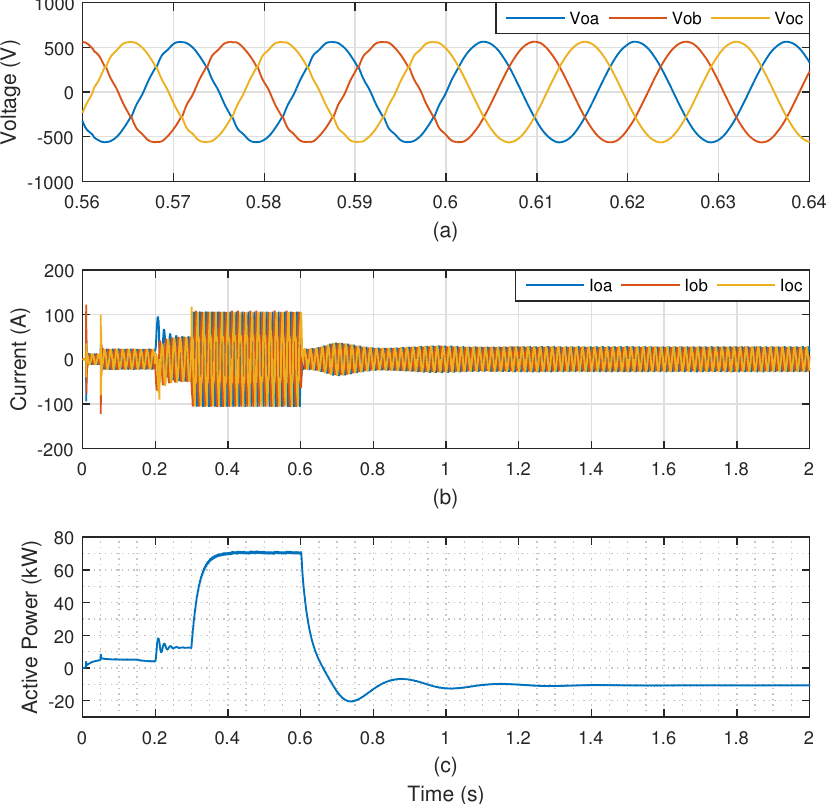
Figure 14. AC microgrid during power flow reversion. ( a ) Output voltage, ( b ) output current, and ( c ) active